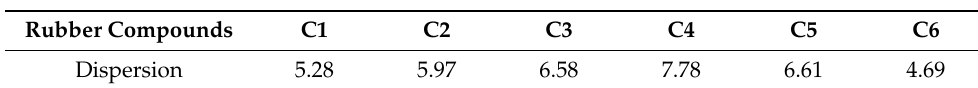
Figure 8. Dispersion images (the scale bar is 100:1). Table 6. Dispersion values.